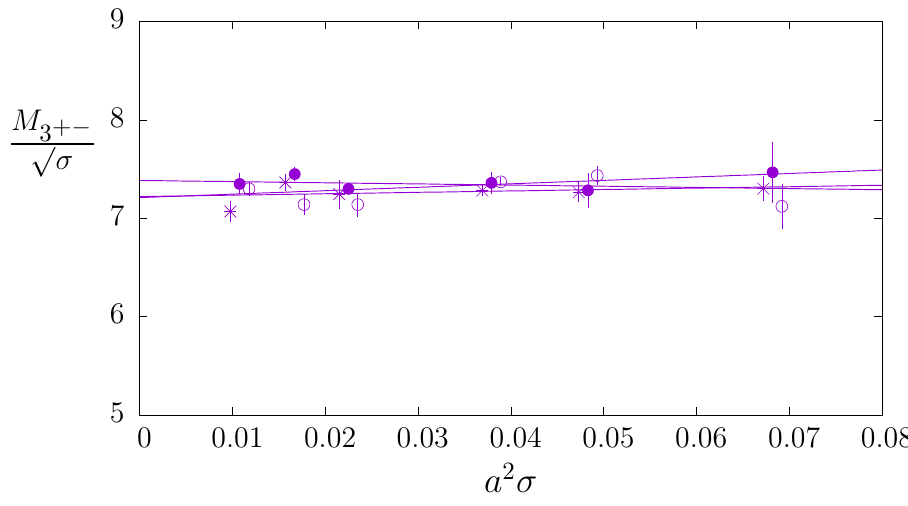
Figure 21 . Continuum extrapolation of the lightest J PC = 3 + − glueball as obtained from the lightest A 2 + − state ( • ), the first excited T 1 + − state ( ◦ and triply degenerate) and the lightest T 2 + − states ( ? and triply degenerate). Hence the seven components of the J = 3 ground state.